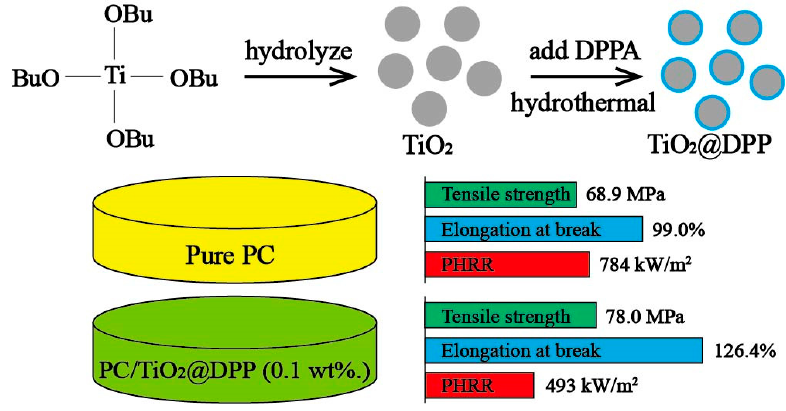
Figure 6. Schematic representation of the formation of TiO 2 @DPP and the enhancement of the composites [43]. Reproduced with permission from [Yunxia Wei et al.], [Applied Materials]; published by [American Chemical Society], 2018.